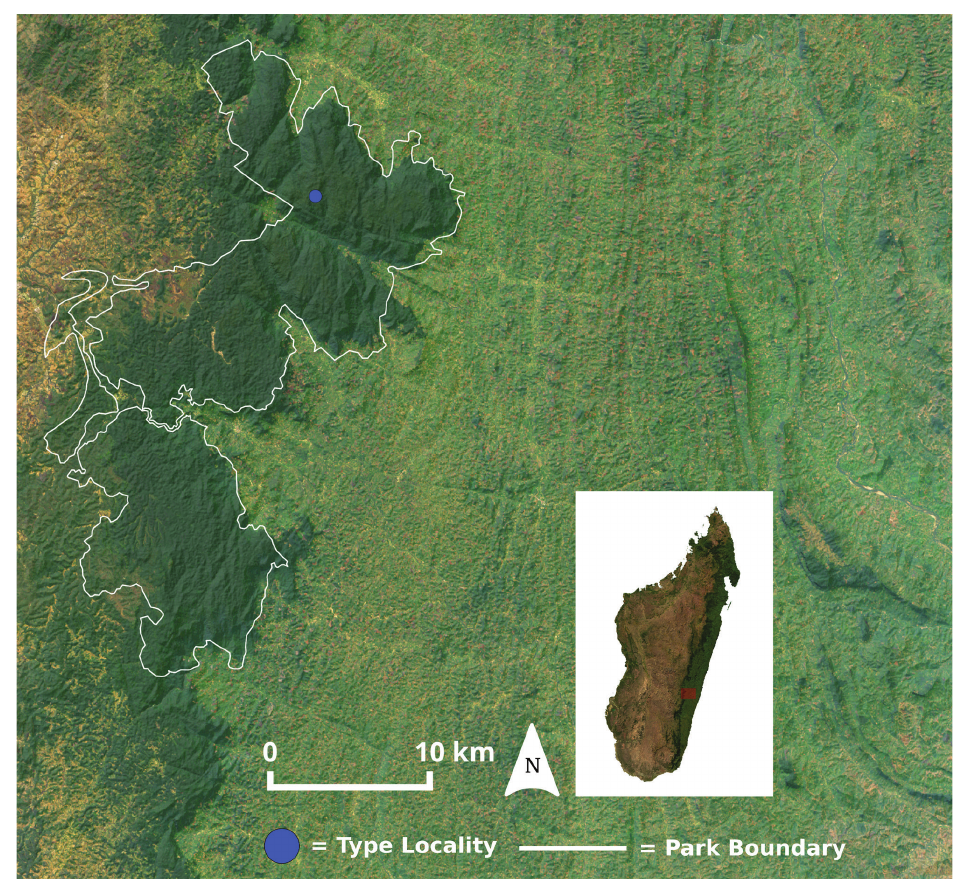
Figure 2. Map of Ranomafana National Park and the type locality of Rhombophryne nilevina sp. n.. Map is a composite of Landsat 8 satellite imagery and a hillshade layer created from SRTM 1 Arc-Second Global digital elevation data. Data available from the U.S. Geological